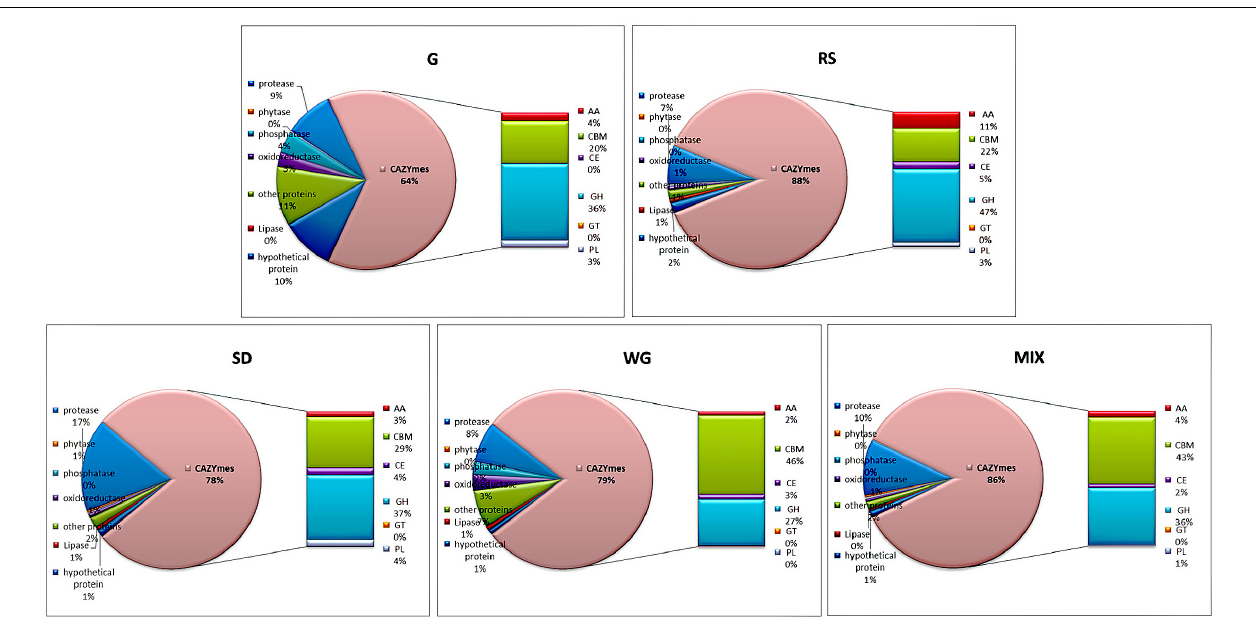
FIGURE 3 | Proportion of the secretome of Morchella importuna in five different culture media. G, CYM medium; RS, glucose-free CYM containing 2% rice straw powder; SD, glucose-free CYM containing 2% sawdust powder; WG, glucose-free CYM containing 2% wheat grain powder; MIX, media containing equal proportions of rice straw, sawdust, and wheat grain